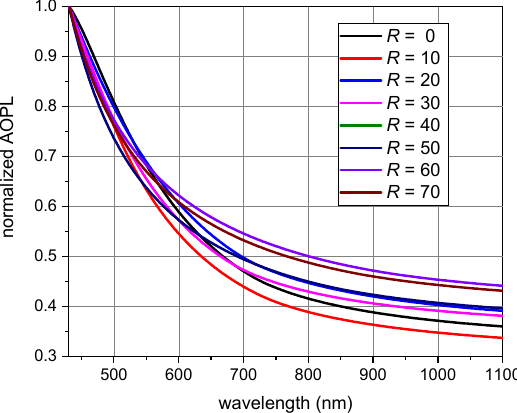
Figure 5. Spectral dependence of normalized apparent OPL (AOPL).